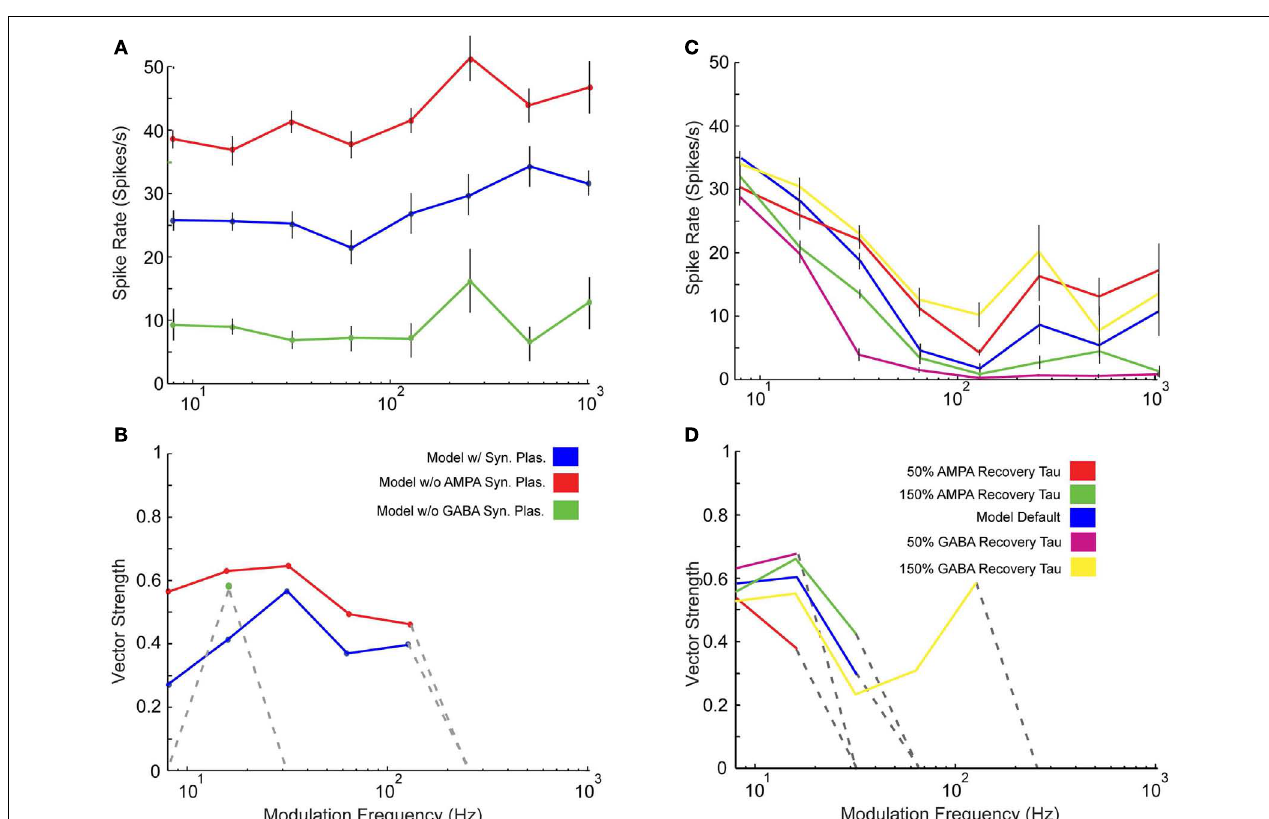
2VCN and 4 DNLL high-pass inputs under normal GABA A and AMPA recovery time constants (blue) , 50% reduction in AMPA (red) or GABA A (purple) , or 150% increase in AMPA (green) or GABA A (yellow) time constants. Synchrony range is increased with longer recovery time but decreased with shorter recovery time. Modulation frequency in Hz is marked along the X -axes for (A–D) , mean firing rate in spikes/s is marked along the Y -axes in (A,C) and vector strength is marked along the Y -axes in (B,D)